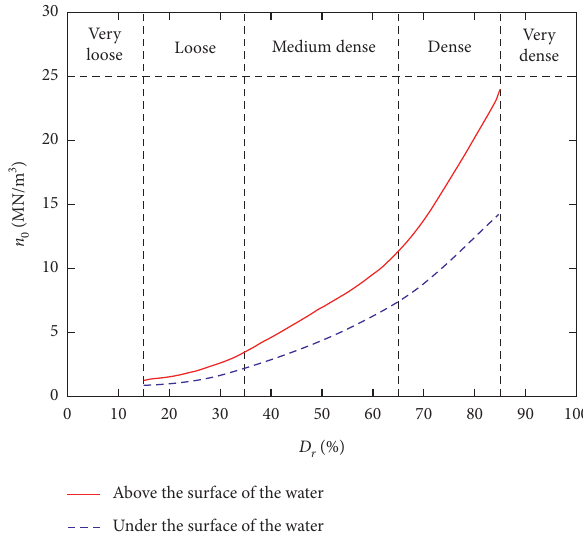
Figure 2: Relationship curve between n 0 and D r of sand. Table 1: Critical pile length.